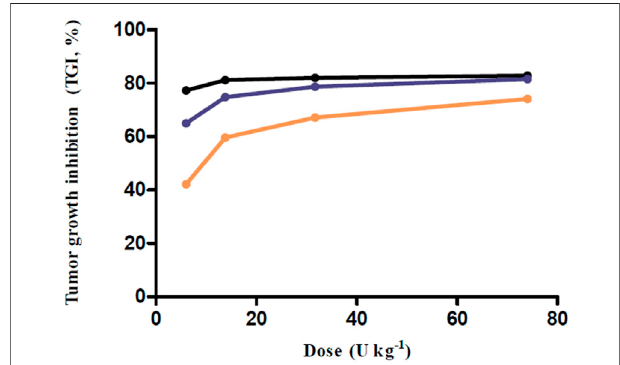
FIGURE 5 | Dose-response relationship for multiple-dose simulations. Black line, Q.D. as a dose regimen; Blue line, Q.3.D. as a dose regimen; Orange line, Q.W. as a dose regimen; Every closed circle, observed TGI